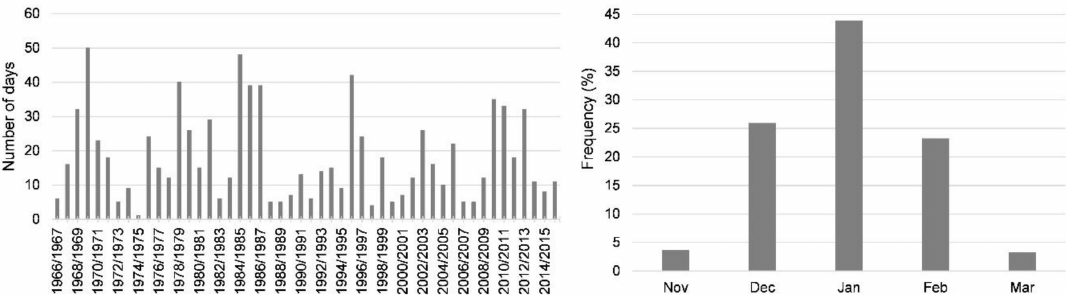
Figure 3. Number of cold days in the period 1966/67–2015/16 and the frequency of occurrence of cold days in months.